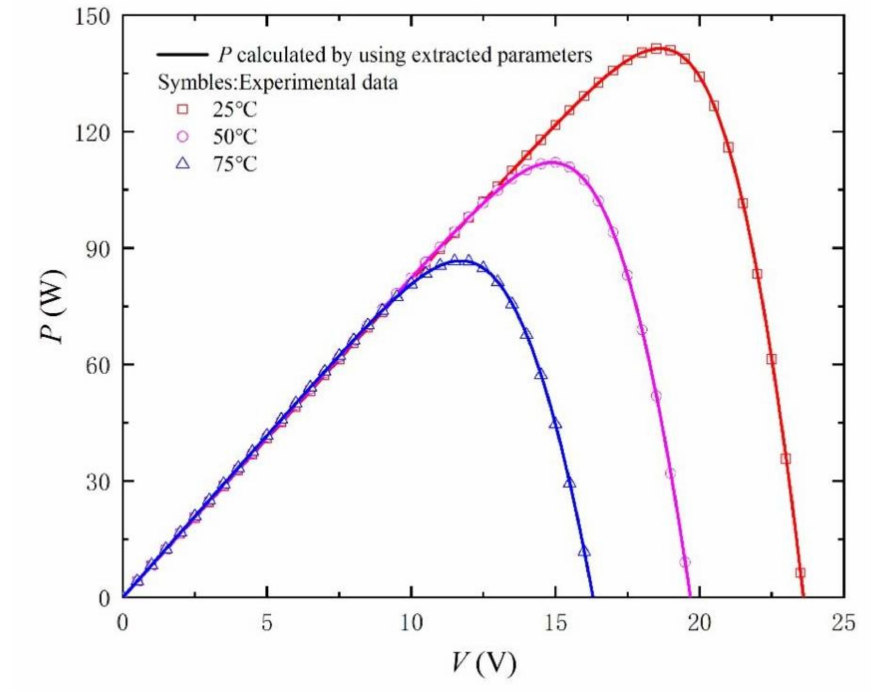
Figure 13. P-V curves measured from experimental data [33] at G = 1000 W/m 2 and different temperatures, and calculated by using the extracted parameters listed in Table 4.